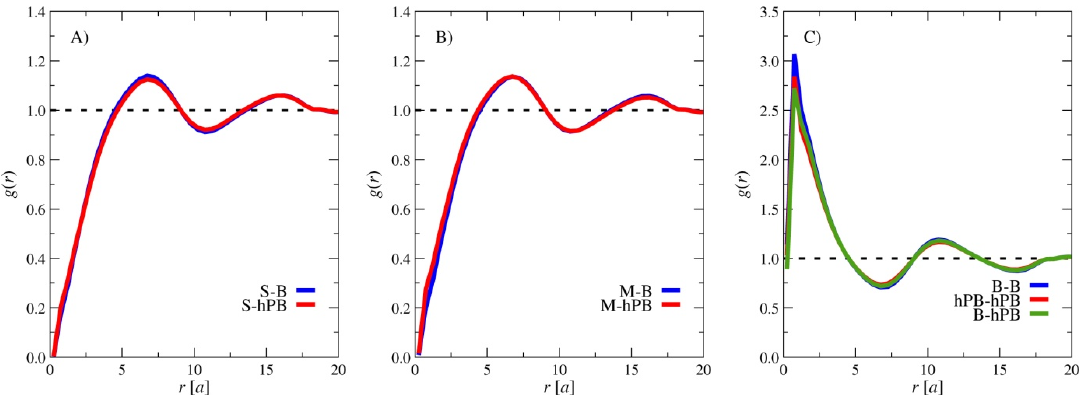
Figure 5. Radial pair distribution function, g ( r ) , between S, B, and M monomers in the system for φ = 75% hPB.